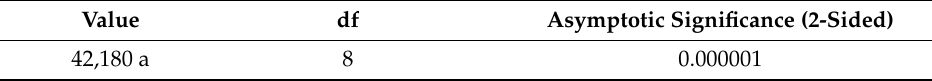
Table 11. Chi-square tests.